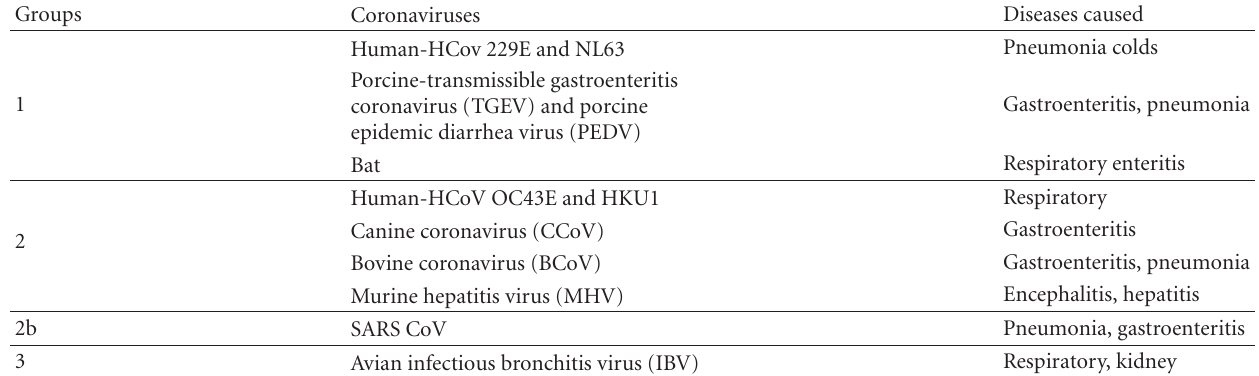
Table 1: Categorization of various animal coronaviruses of interests by genetic and antigenic proximity [4, 5, 16]. The viruses included are